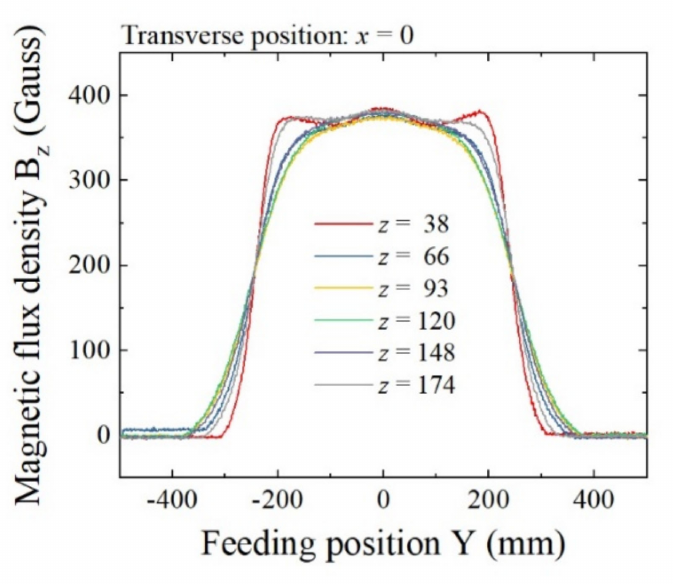
Figure 10. Overlapping expression of the field variation B z on feeding position Y as a parameter of vertical height Z. (Unit of z :